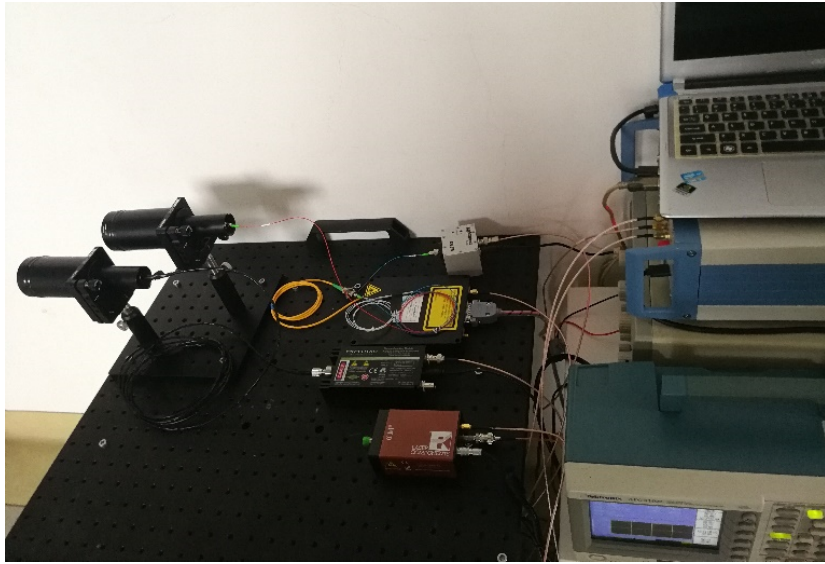
Figure 9. Experimental platform of the true random code photon counting LIDAR. Table 1. Main Parameters of the LIDAR System.